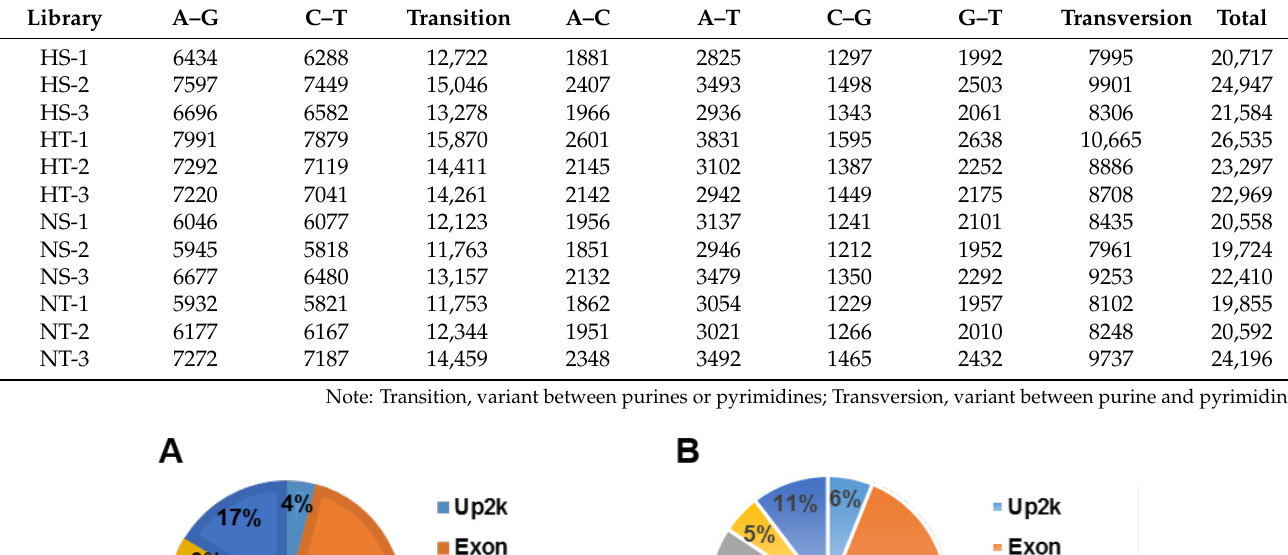
Table 4. Statistics of SNP variant type and number.